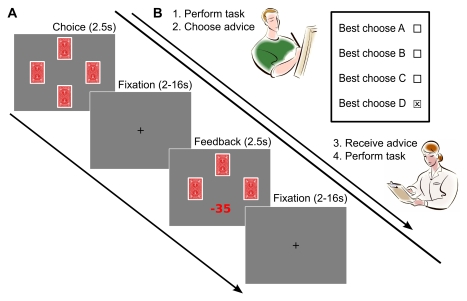
Experimental design.The task implemented key features of a realistic social learning situation, in which the learner receives well-intentioned advice prior to individual learning, but good advice is not certain. (A) In the learning task, participants repeatedly chose from one of four card decks associated with different gains and losses (c.f. Figure S1), with the goal of maximizing cumulative rewards. Each trial started with the presentation of the four decks. Participants had 2.5 s to choose a deck. After a variable fixation interval, feedback was presented for 2.5 s. (B) Advisors performed the 4-armed bandit task in the laboratory and indicated their advice on a form, which advice-receivers obtained before performing the task in the scanner.